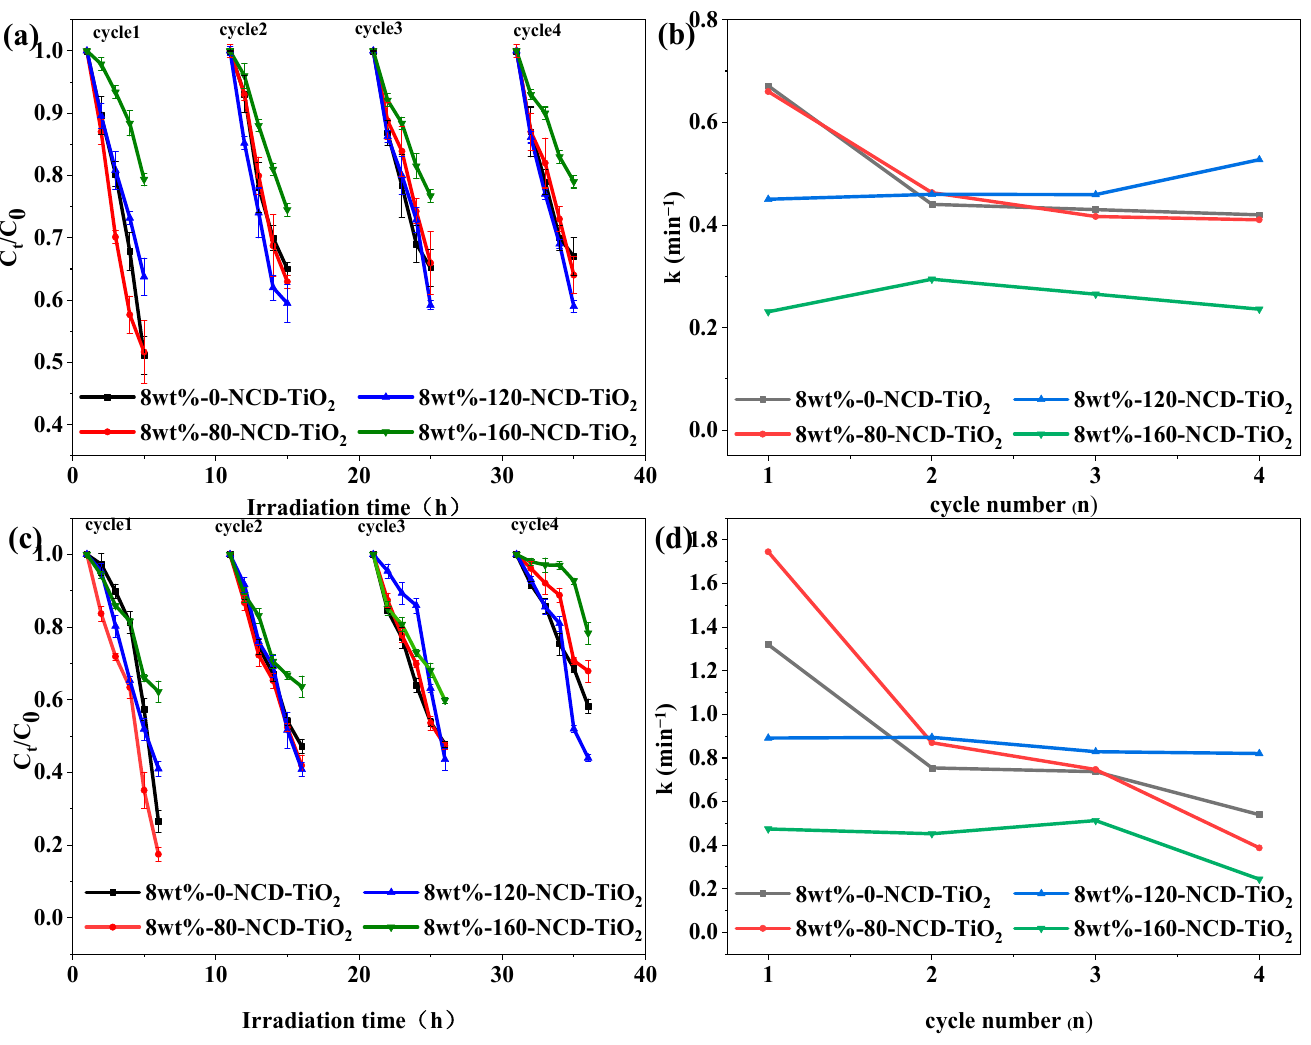
Figure 5. ( a ) Degradation of phenol and ( b ) the reaction rate constant k for the photocatalytic degradation of phenol during four cycles in the presence of the PVA/NCD-TiO 2 hybrid films treated at different temperatures; ( c ) degradation of LEV and ( d ) the reaction rate constant k for the photocatalytic degradation of LEV during four cycles in the presence of the PVA/NCD-TiO 2 hybrid films treated at different temperatures.